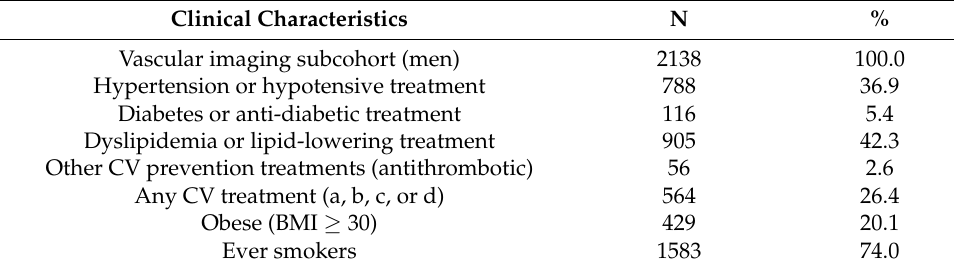
Table 1. Clinical data for participants in the cross-sectional study. Clinical